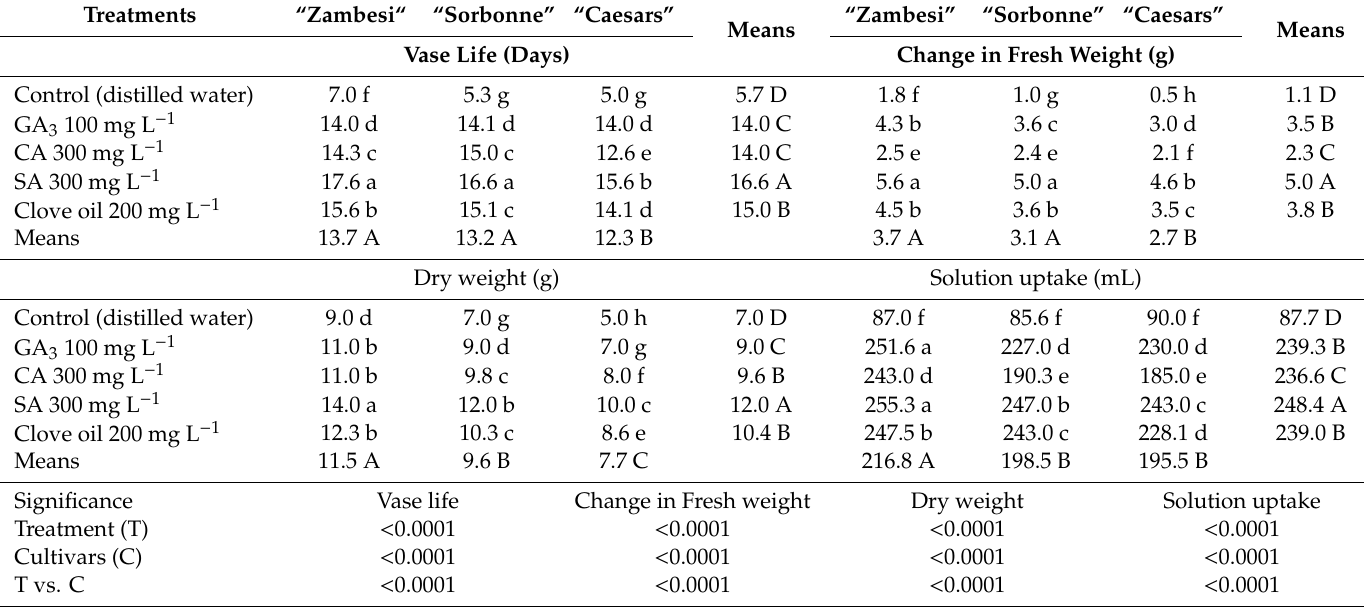
Table 1. Comparative analysis of the e ff ects of di ff erent vase solutions on the vase life, stem fresh weight, stem dry weight, and solution uptake of three cultivars of cut lily